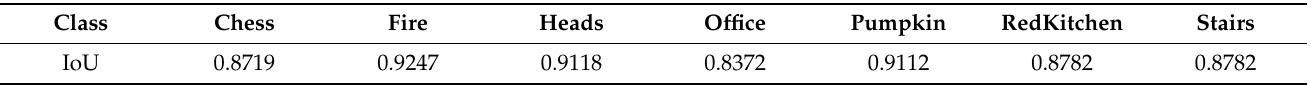
Figure 9. Visualize the pose estimation of objects in the 7-Scenes Dataset. The green box is the ground truth, red box is the prediction. ( a ) chess; ( b ) fire; ( c ) head. Table 2. IoU of the ground truth box and estimated box poses for each class.